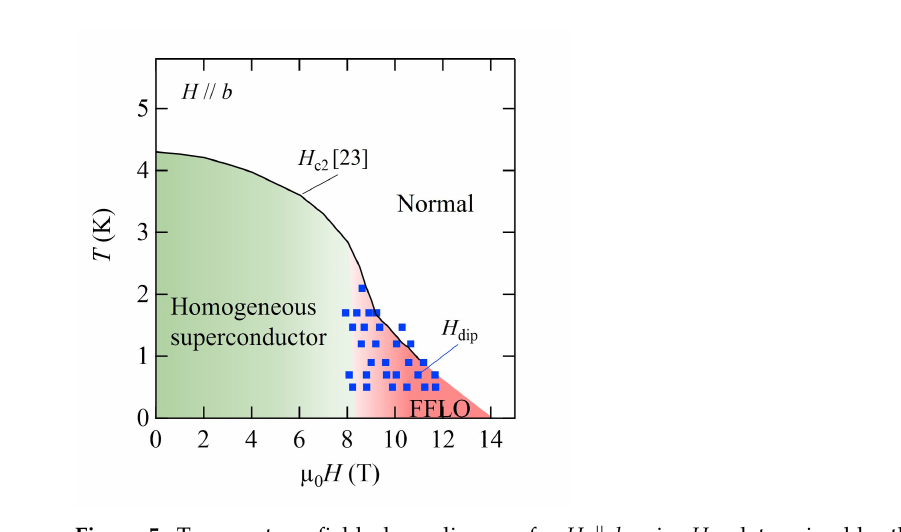
Figure 5. Temperature–field phase diagram for H (cid:107) b axis. H c2 determined by the specific-heat measurements is indicated by a solid curve [23].